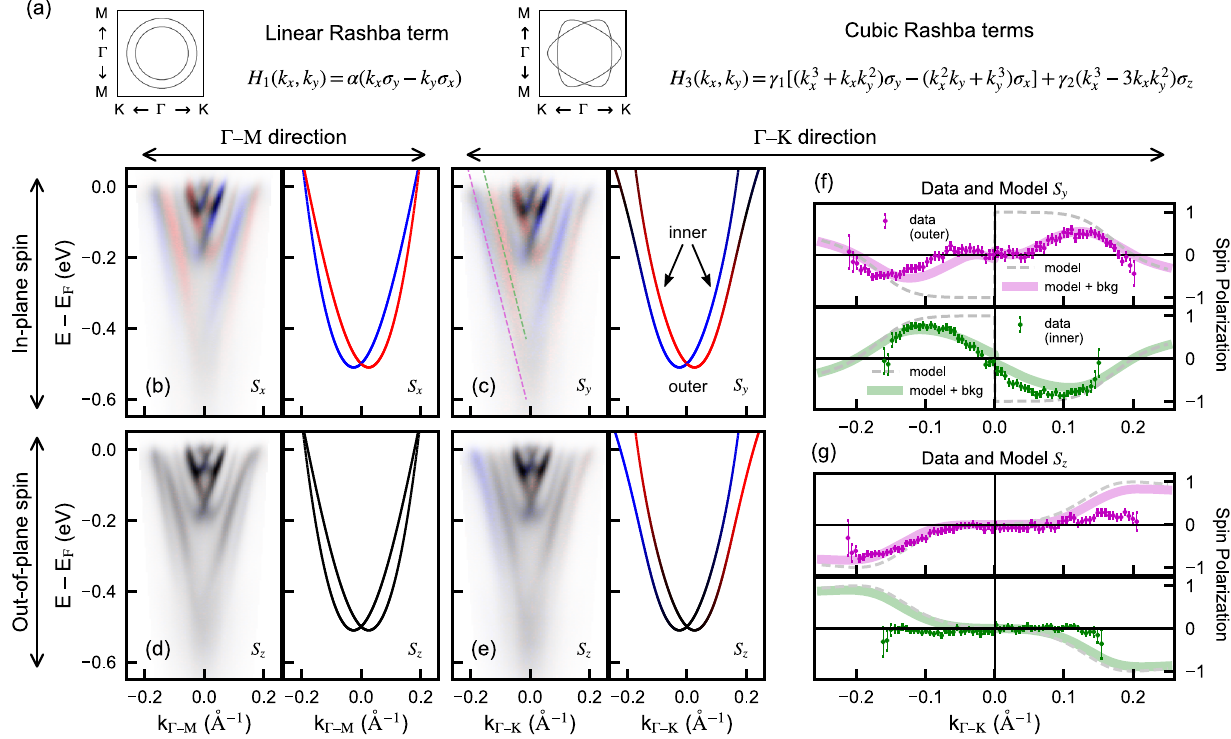
Fig. 5 Higher-order Rashba model. a Representative constant-energy contours of the linear and cubic Hamiltonians. b , c Comparison between experiment (measured with p -polarized light) and the cubic Rashba model for the in-plane spin component along Γ -M and Γ -K, respectively. d , e Same, but for the out-of-plane spin component. f , g Quantitative comparison between the experimentally-measured spin- polarization and the results of the third-order Rashba model along Γ -K for in-plane and out-of-plane spins, respectively. Each spin-polarization curve is extracted by integrating an energy window of ±45 meV along the outermost sub-bands, as indicated by the guides to the eye in ( c ). In addition to the plotted statistical error bars, we estimate a fractional systematic uncertainty in the measured spin-polarization of ±10%. An energy-dependent signal-to-background ratio is incorporated into the model to permit a direct comparison with the data (see Supplementary Note